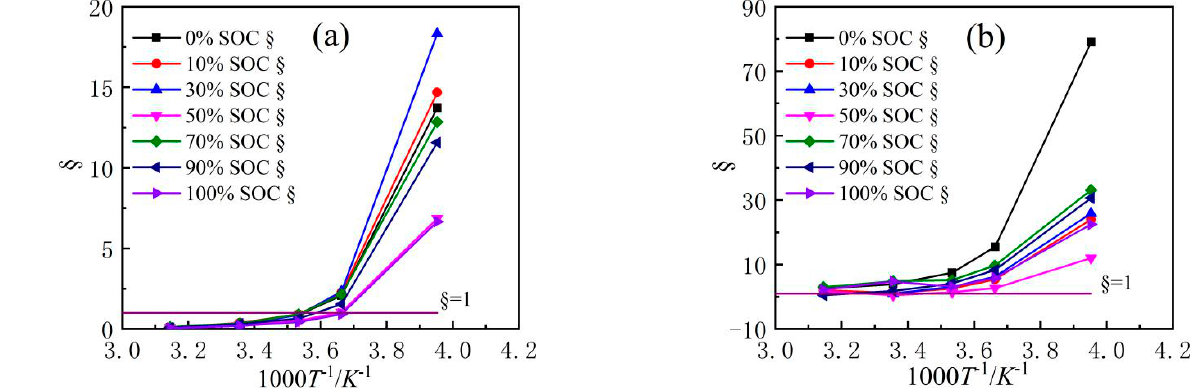
Figure 12. Variations of the § with 1000 . T − 1 ( a ) Anode ( b ) Cathode.